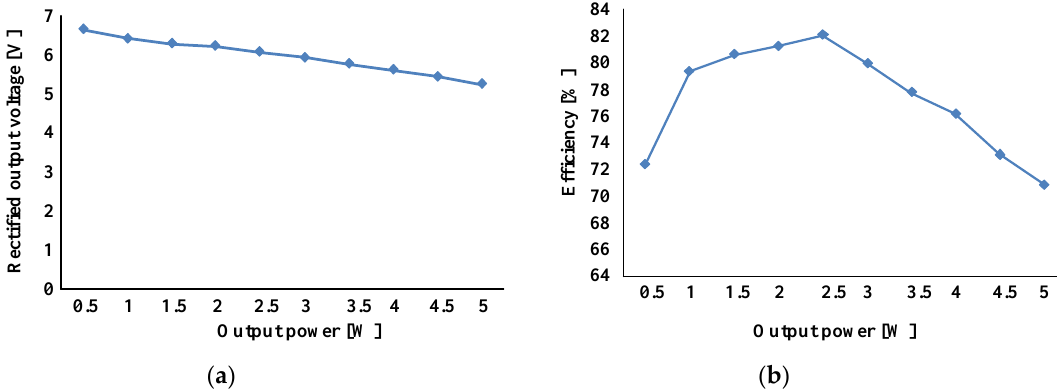
Figure 16. Output voltage and efficiency according to load variation: ( a ) output voltage; ( b ) efficiency.